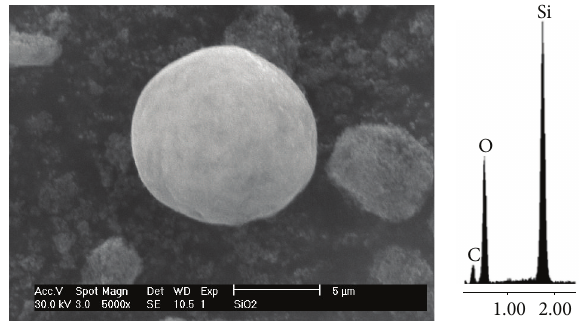
Figure 3: Secondary electron SEM image of a spherical particle rich in SiO 2(